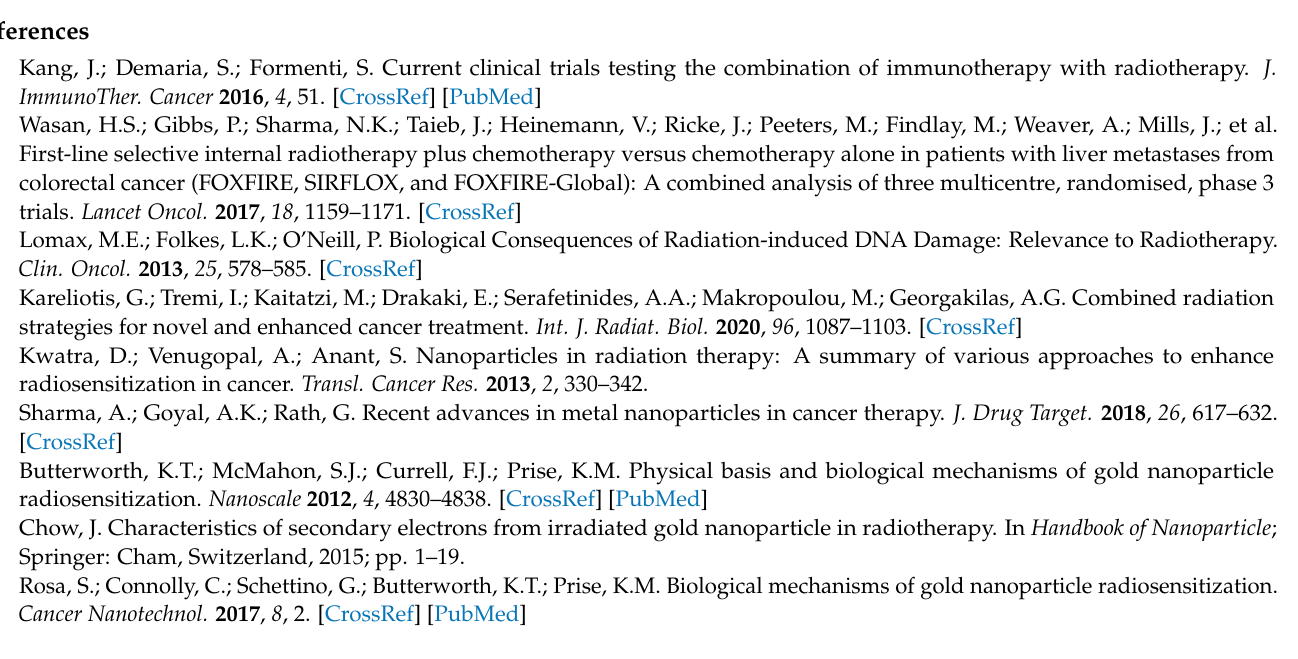
Table S1: Fitted parameters of the LQ Model for experimental data shown in Figure 7a; Table S2: Fitted parameters of the LQ Model for experimental data shown in Figure